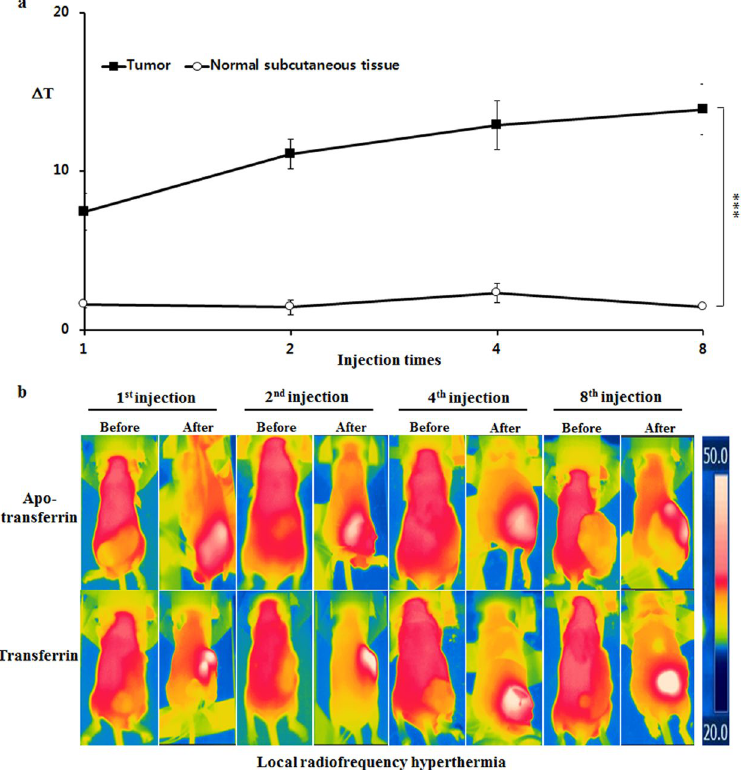
Figure 4. The selective temperature elevations of cancer tissue by a local 13.56 MHz radiofrequency hyperthermia was positively correlated with ferric ion accumulation. Accumulation of ferric ion in cancer cells was achieved by repeated i . v . injection of transferrin as described in Supplementary Fig. 2. The temperature of tumor tissues or normal subcutaneous tissues was measured before and after local hyperthermia for temperature change ( Δ T) calculation. ( a ) The comparative analysis showed that accumulation of ferric ion by repeated i . v . injections of transferrin elevated temperature higher in cancer tissue than in normal subcutaneous tissues in a local hyperthermia. ( b ) Representative images of transferrin injection group were shown along with apotransferrin injection group. The values represent the mean ± standard deviation ( n = 6). A paired Student’s t-test was used for the statistical analysis; *** p <